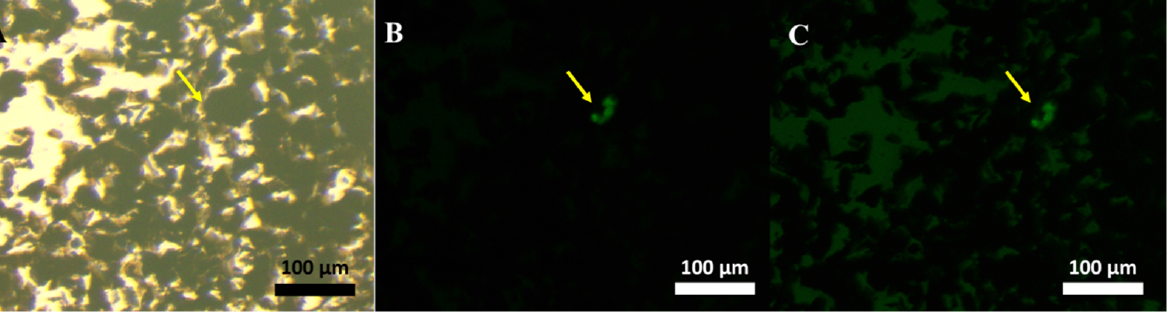
Figure 4. FL images after LF-exo conjugation with Ag/IO-GRP and AF488-CD9 via antibody and exosome binding: ( A ) bright field image, ( B ) FL image, and ( C ) bright field and FL merged condi- tion image.